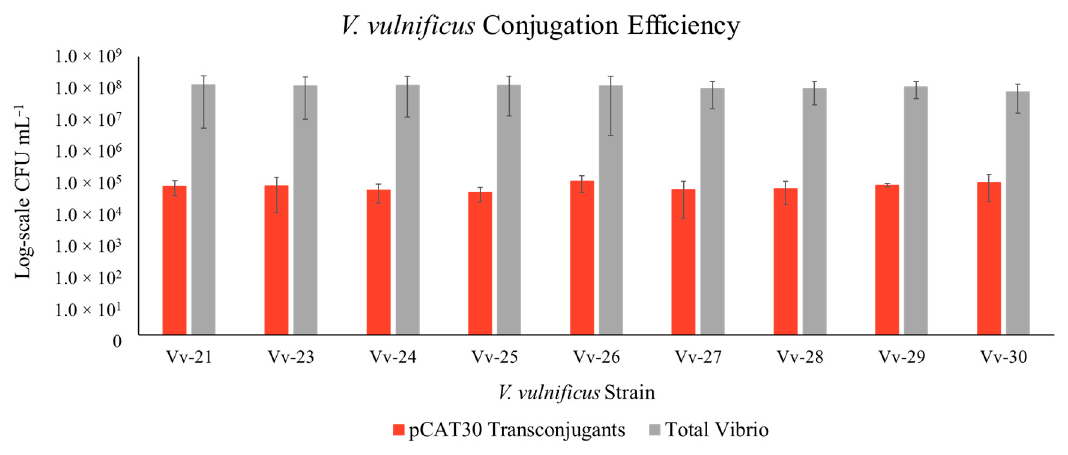
Figure 4. The conjugation efficiency of pCAT30 with V. vulnificus . Red bars represent the V. vulnificus